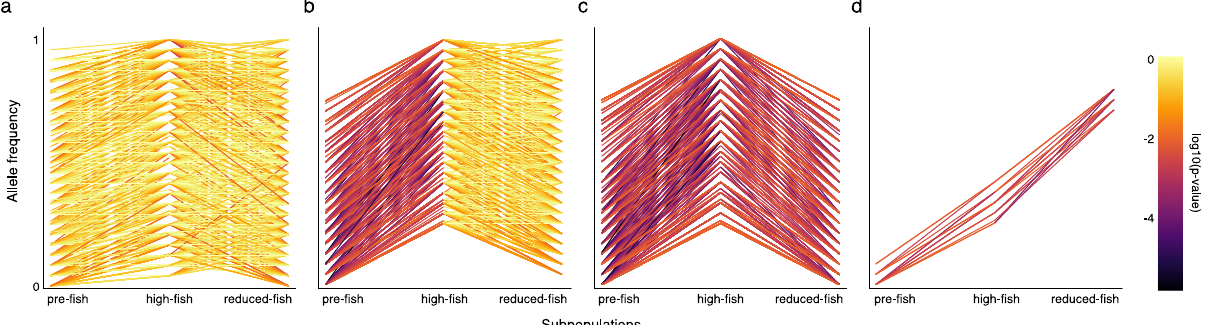
Fig. 2 Allele-frequency changes at SNP variants through time in OHZ pond, Belgium. a A random subset of 1000 SNPs showing no signi fi cant change in allele frequency over the entire period. b A random subset of 1000 outlier SNPs in the pre- fi sh to high- fi sh transition that exhibit no signi fi cant changes (Waples test, P values > 0.01) during the high- fi sh to the reduced- fi sh transition. Many SNPs show a tendency for a reversal in this data-set. c A random subset of 1000 out of the 1753 SNPs that show signi fi cant changes in allele frequency in the pre- fi sh to high- fi sh transition and also show a signi fi cant (Waples test, P value < 0.01) partial reversal of this change during the high- fi sh to reduced- fi sh transition. d All 18 SNPs are outlier SNPs in the pre- fi sh to high- fi sh transition and also show a further signi fi cant (Waples test, P value < 0.01) increase in allele frequency in the high- fi sh to reduced- fi sh transition. The color coding signi fi es the log10 signi fi cant changes in allele frequency for a speci fi c transition (Waples test). Panels a , b and c are limited to 1000 SNPs to facilitate graphical